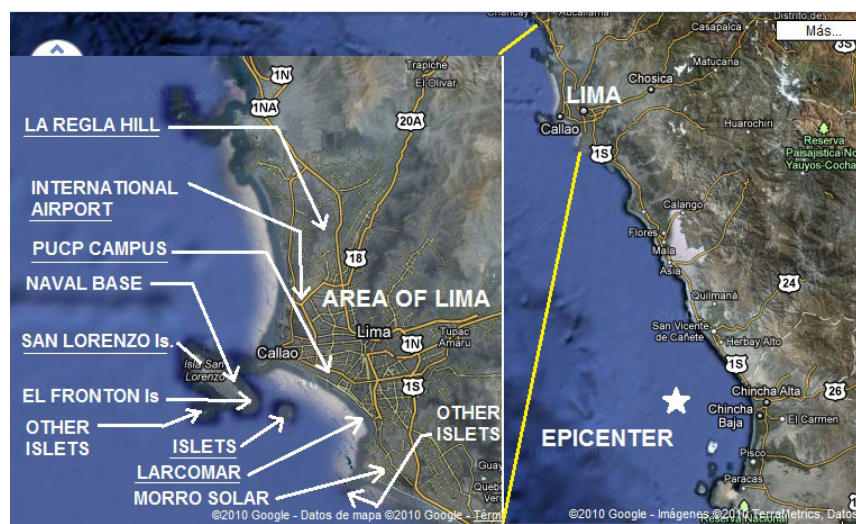
Fig. 1. To the right, the map of central Peru and the location of the epicenter. To the left, the area of Lima showing referenced locations.